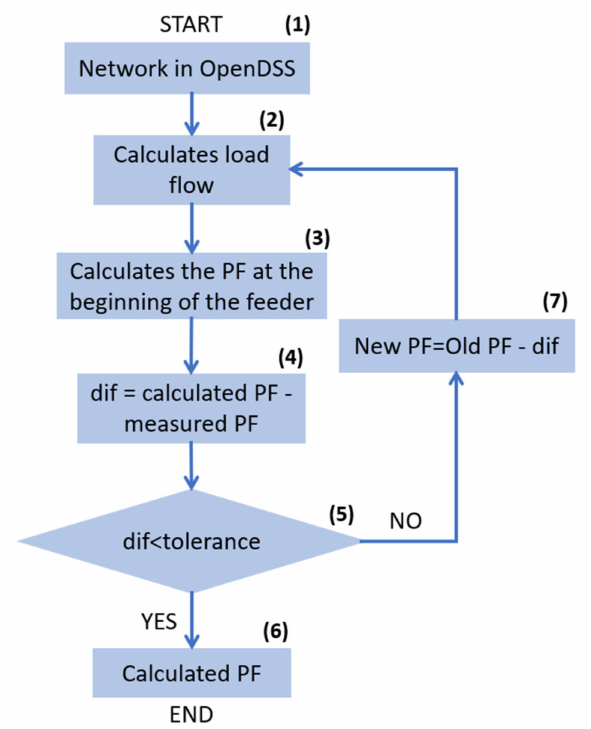
Figure 3. Flowchart of the load power factor adjustment